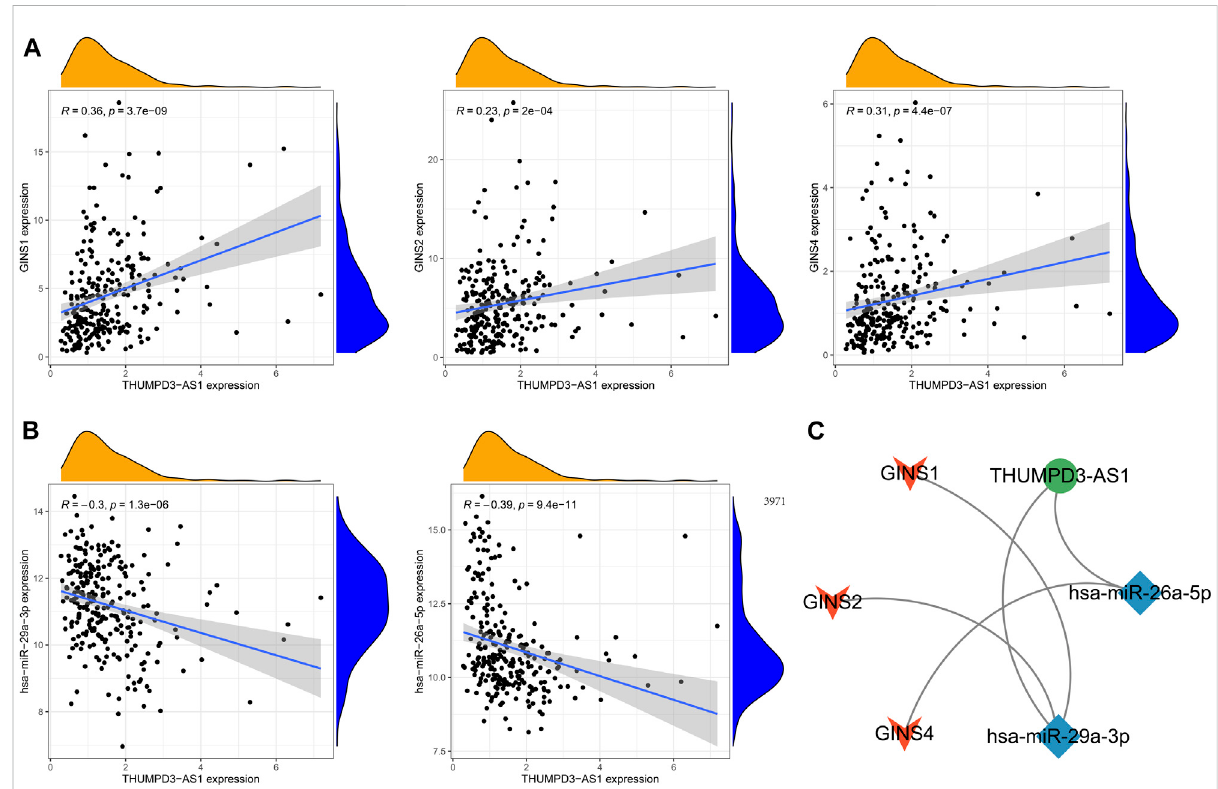
FIGURE 12 Thesub-networkoflncRNATHUMPD3-AS1,miRNAandGINSsubunitsinSARC.TheGINSsubunits positivelycoexpressedwithTHUMPD3-AS1 (A) . The miRNAs negatively co-expressed with THUMPD3-AS1 (B) . The network diagram demonstrated a sub-network of THUMPD3-AS1-miRNA- GINS (C)